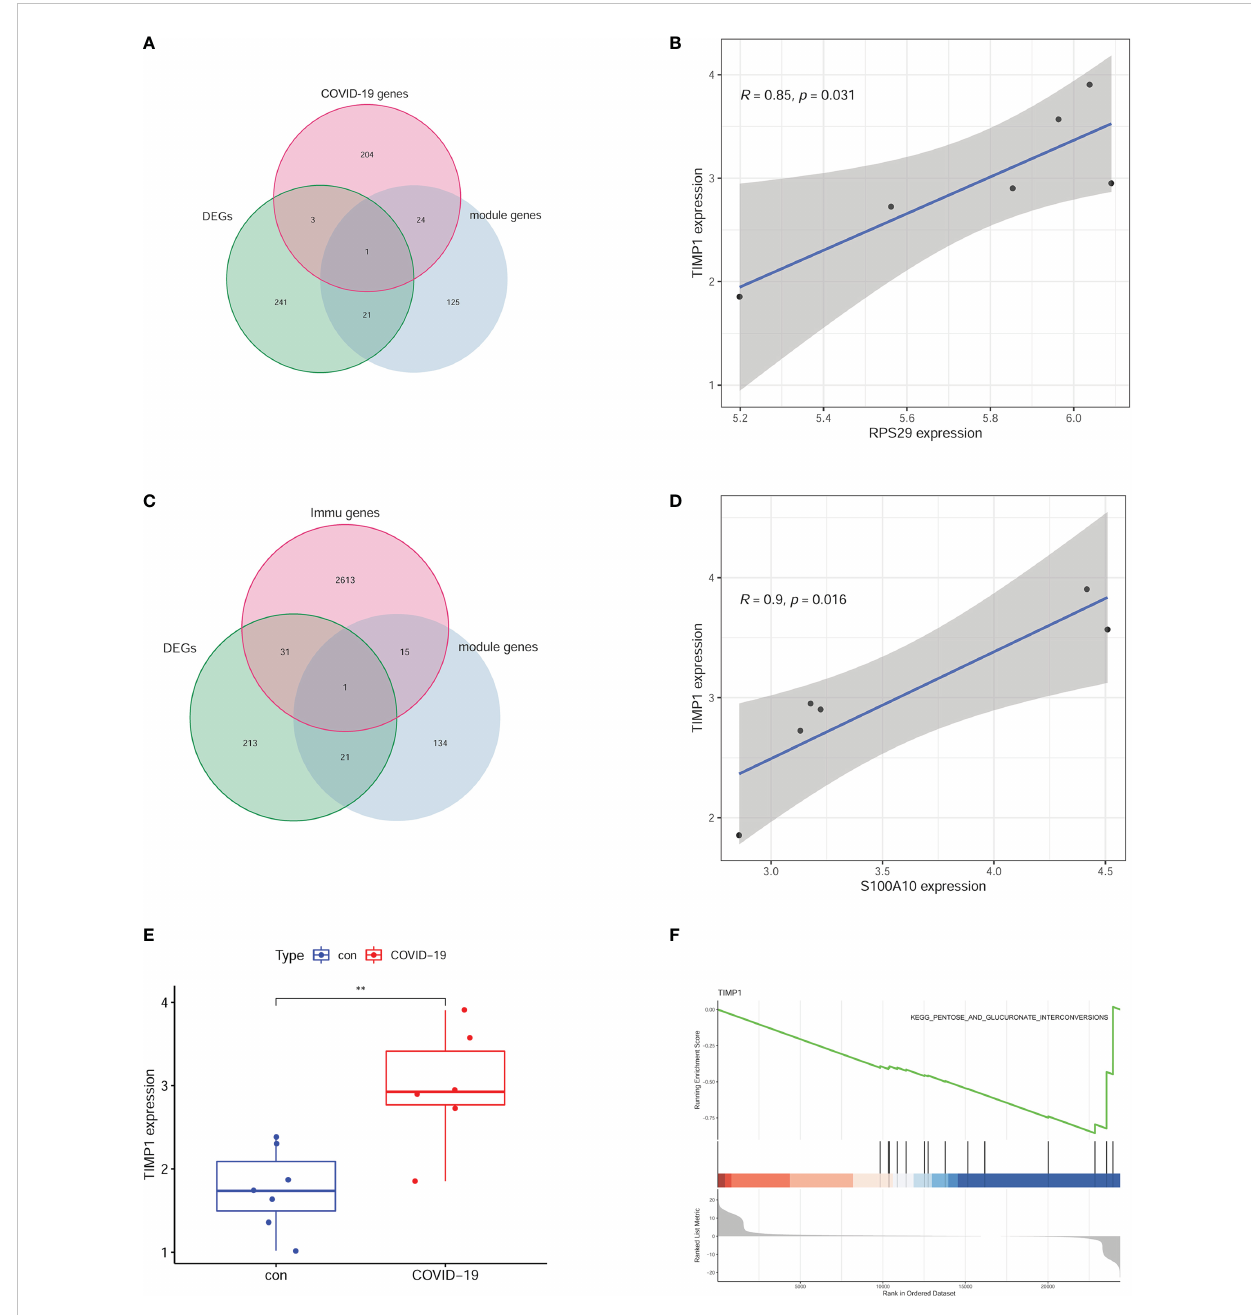
FIGURE 5 Critical molecules based on the signal pathway. (A) RPS29 was selected by intersecting the DEGs, MEpurple module genes, and COVID-19 genes. (B) the correlative analysis between RPS29 and TIMP1. (C) S100A10 was chosen by intersecting the DEGs, MEpurple module genes, and immune genes. (D) the correlative analysis between S100A10 and TIMP1. (E) different expressions of TIMP1. (F) GSEA analysis according to TIMP1 expression. **p <